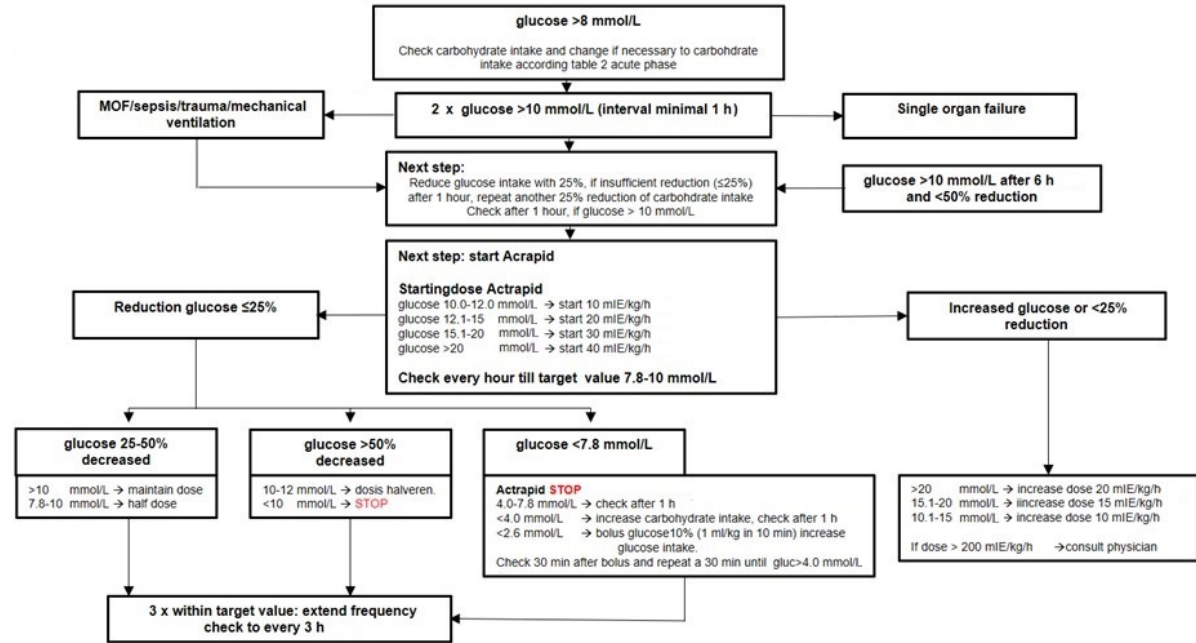
Figure 1. The insulin (Actaprid) protocol for treating hyperglycaemie (non-diabetes). Stop Actrapid if: doses < 5 mIE/kg/h or <20 mIE/kg/h. After 1 h control: if glucose ≤ 10 mmol/L, definitively stop